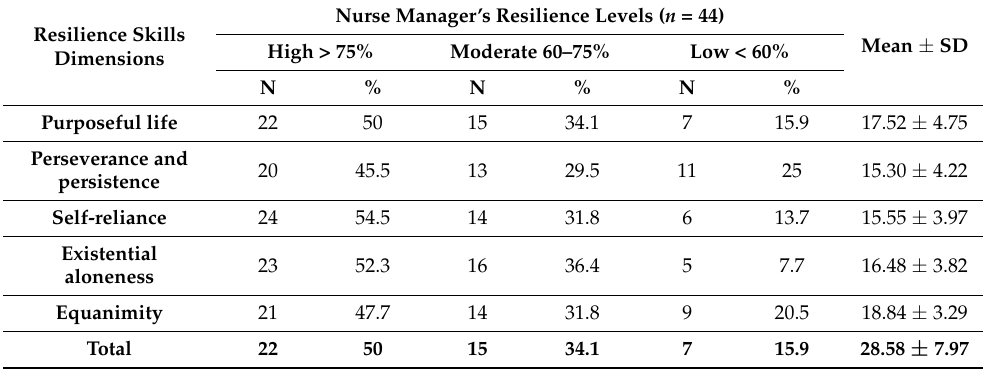
Table 3. Percentage distribution of nurse manager’s resilience skills levels ( n = 44).